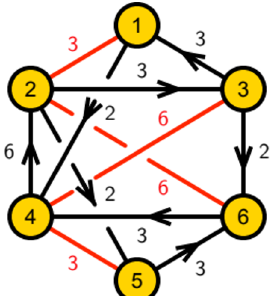
Figure 12 . Quiver for Model